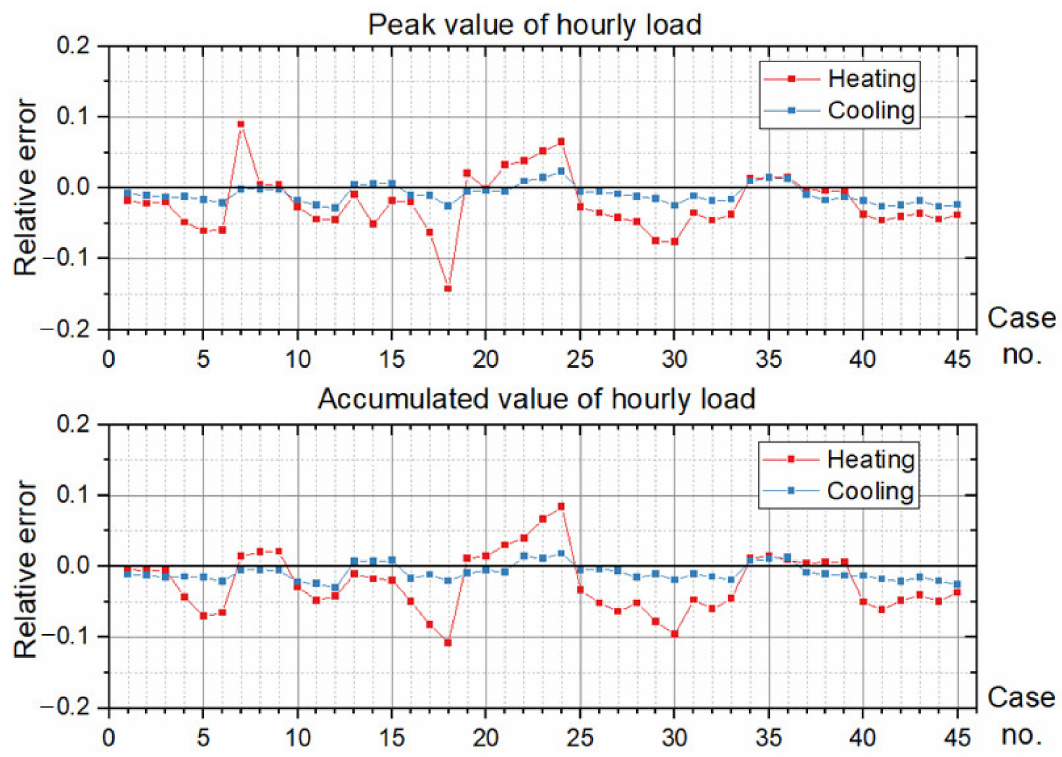
Figure 17. Other indices to evaluate the prediction